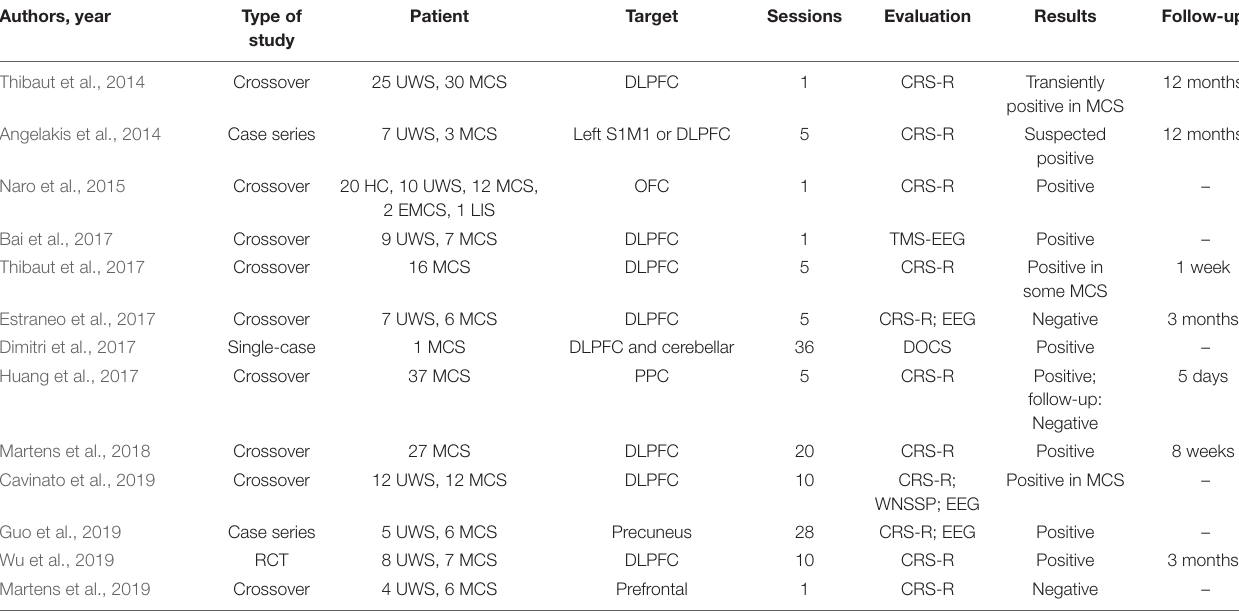
TABLE 1 | Overview of the studies on transcranial direct current stimulation (tDCS) for disorders of consciousness (DOC). Authors,